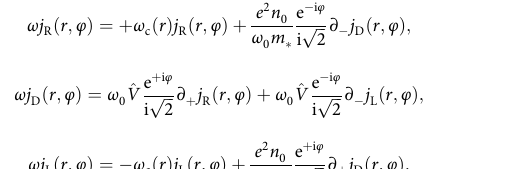
Line cut along x